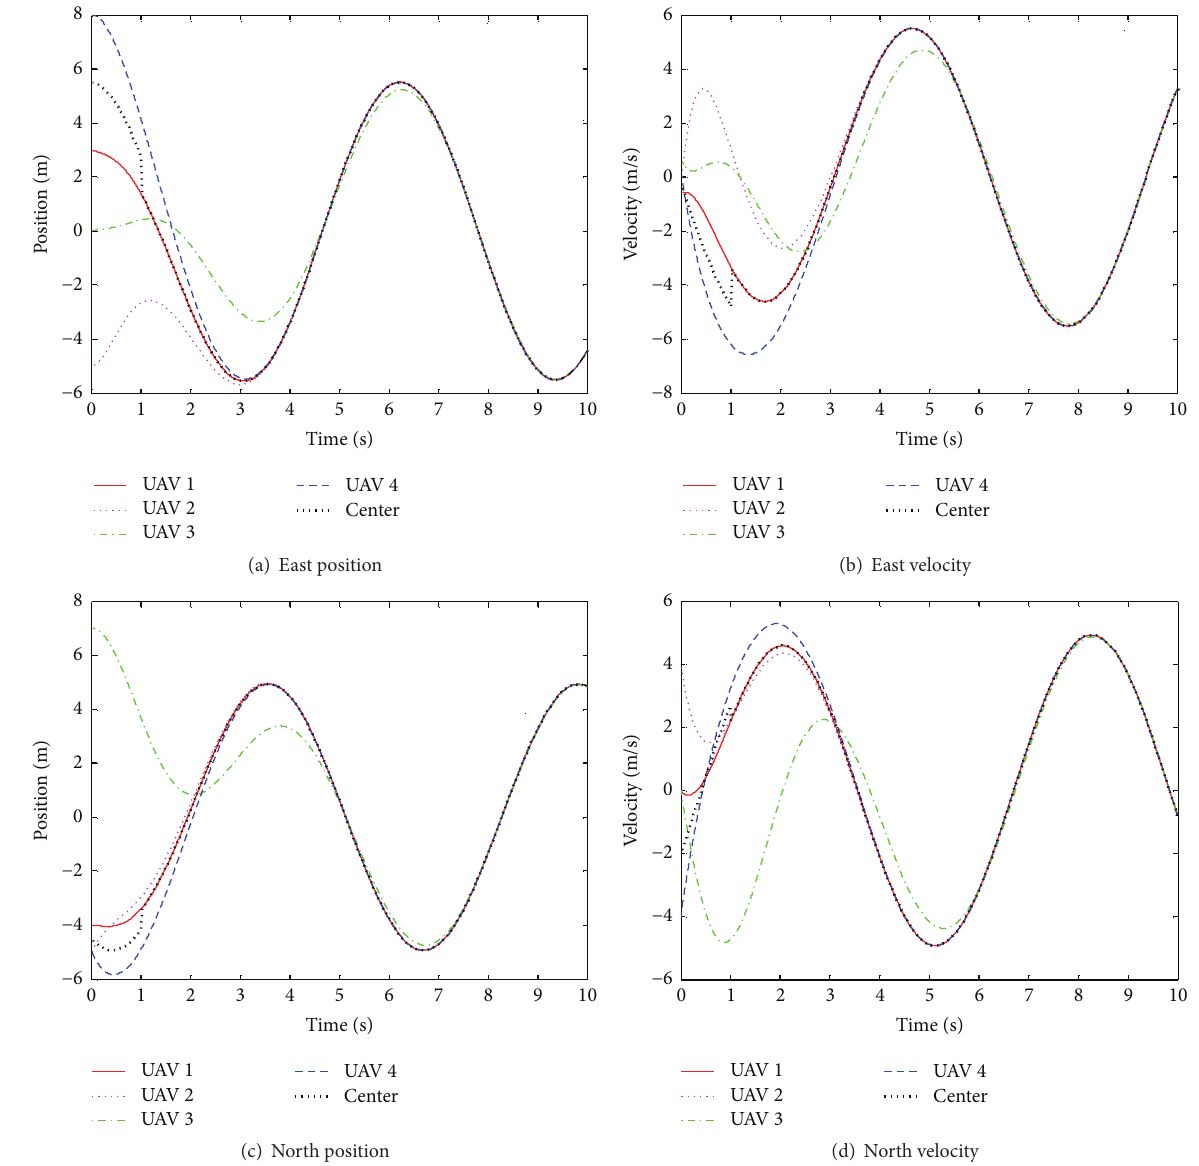
Figure 3: Difference of UAV state and time-varying